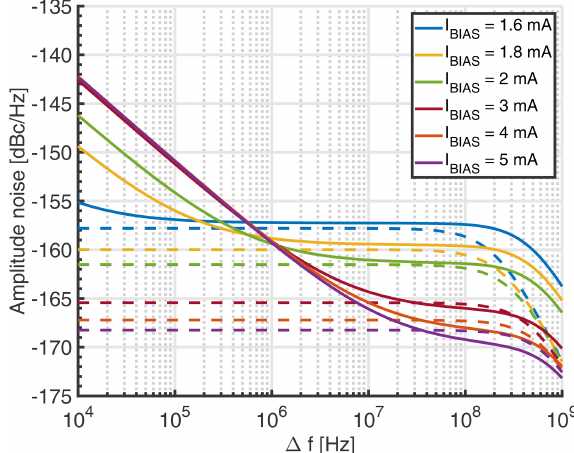
Figure 5. Comparison of the proposed analytical model for the am- plitude noise of an LC tank VCO and GoldenGate simulations. The simulation parameters are identical to those listed in the caption of Fig. 4 except for the bias current I BIAS , which was varied as a parameter to evaluate the range over which the proposed model is valid. Solid lines correspond to the GoldenGate results and dashed lines to the analytical